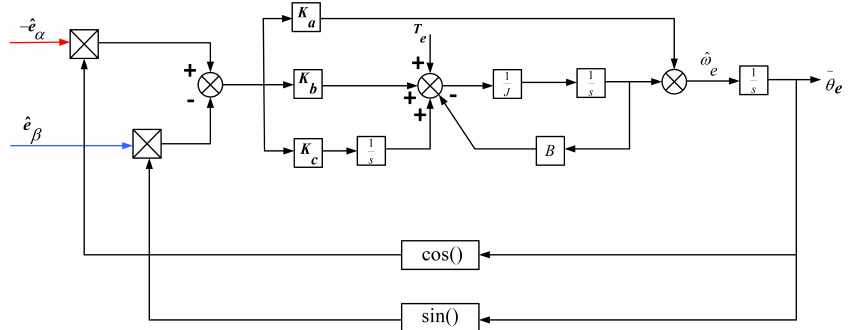
Figure 10. Block diagram of Luenberger observer-based speed and position estimator